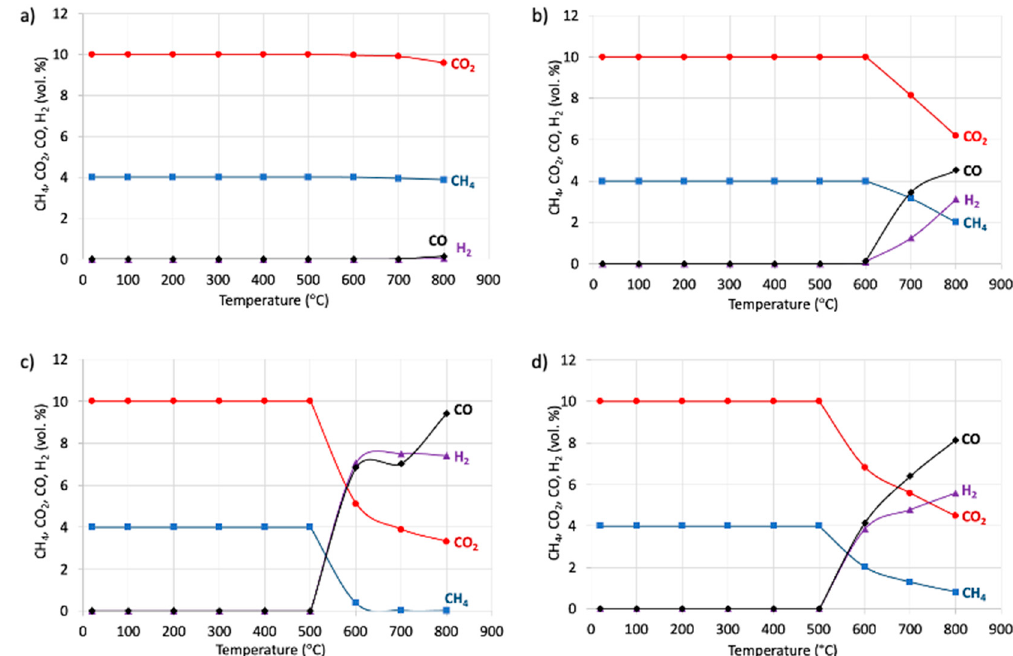
Figure 8. The evolution of CH 4 (blue), CO 2 (red), H 2 (purple) and CO (black) during dry reforming of methane (DRM) catalytic tests in temperature-programmed (TP) mode over CZ/CFF ( a ), Pt-CZ/CFF ( b ), Ni-CZ/CFF ( c ), and Pt-Ni-CZ/CFF ( d ) catalysts. Reaction mixture: 4 vol. % CH 4 , 10 vol. % CO 2 , balanced with Ar. Gas Hourly Space Velocity (GHSV) = 5000 h − 1 .